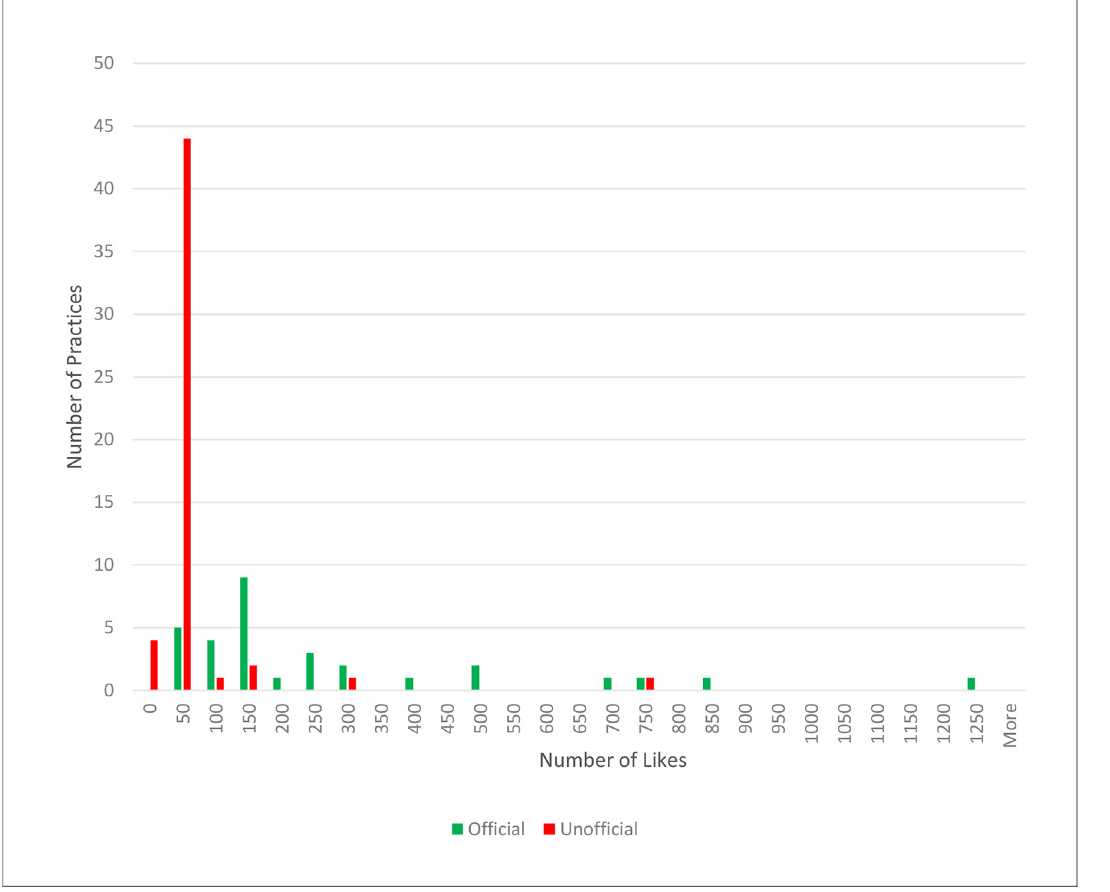
Figure 1. Public engagement indicated by numbers of ’likes’ on official and unofficial Facebook pages